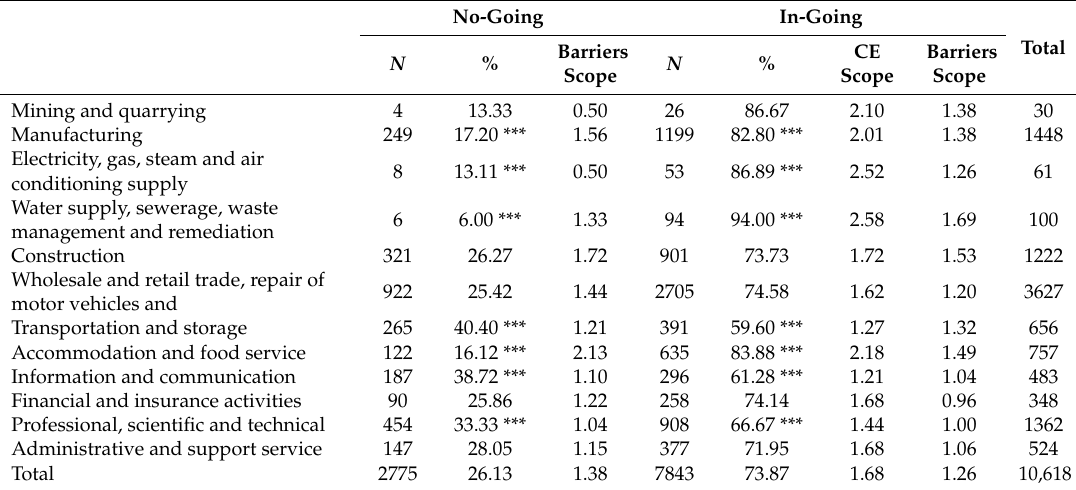
Table 3. Sample distribution. In-Going and No-Going firms.